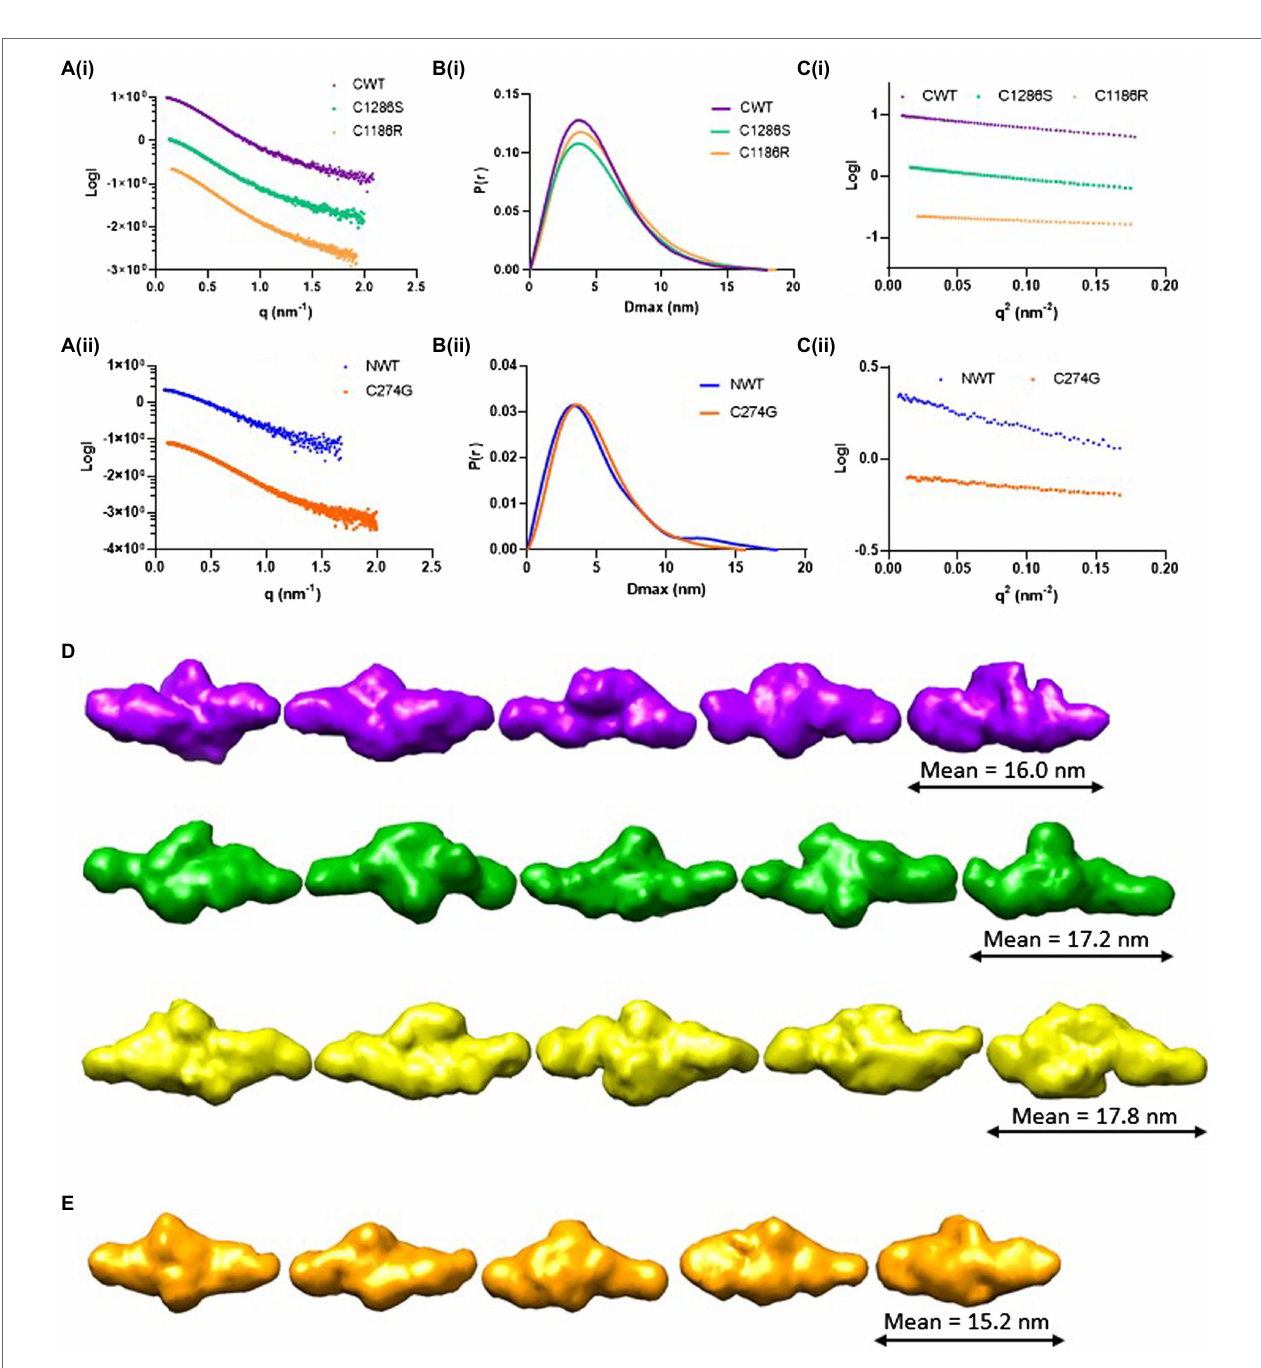
FIGURE 3 | Structural characterisation of LTBP4 N- and C-terminal regions using small angle X-ray scattering. (A) The experimental 1D scattering intensity I plotted as a function of q for (i) CWT, C1286S and C1186R, and (ii) NWT and C274G constructs used for analysis and modelling. (B) The IFT of I vs. q using GNOM, P(r) vs. r for wild type and mutants indicate the maximum dimensions in real space. (C) Guinier plot of the low q region for the (i) CWT, C1286S and C1186R and (ii) NWT and C274G showing linearity. (D) Five example ab initio models generated by DAMMIN are shown each for CWT (purple), C1286S (green) and C1186R (gold) and (E) C274G (orange). Models are shown to the same scale and the average end-to-end length is indicated for each